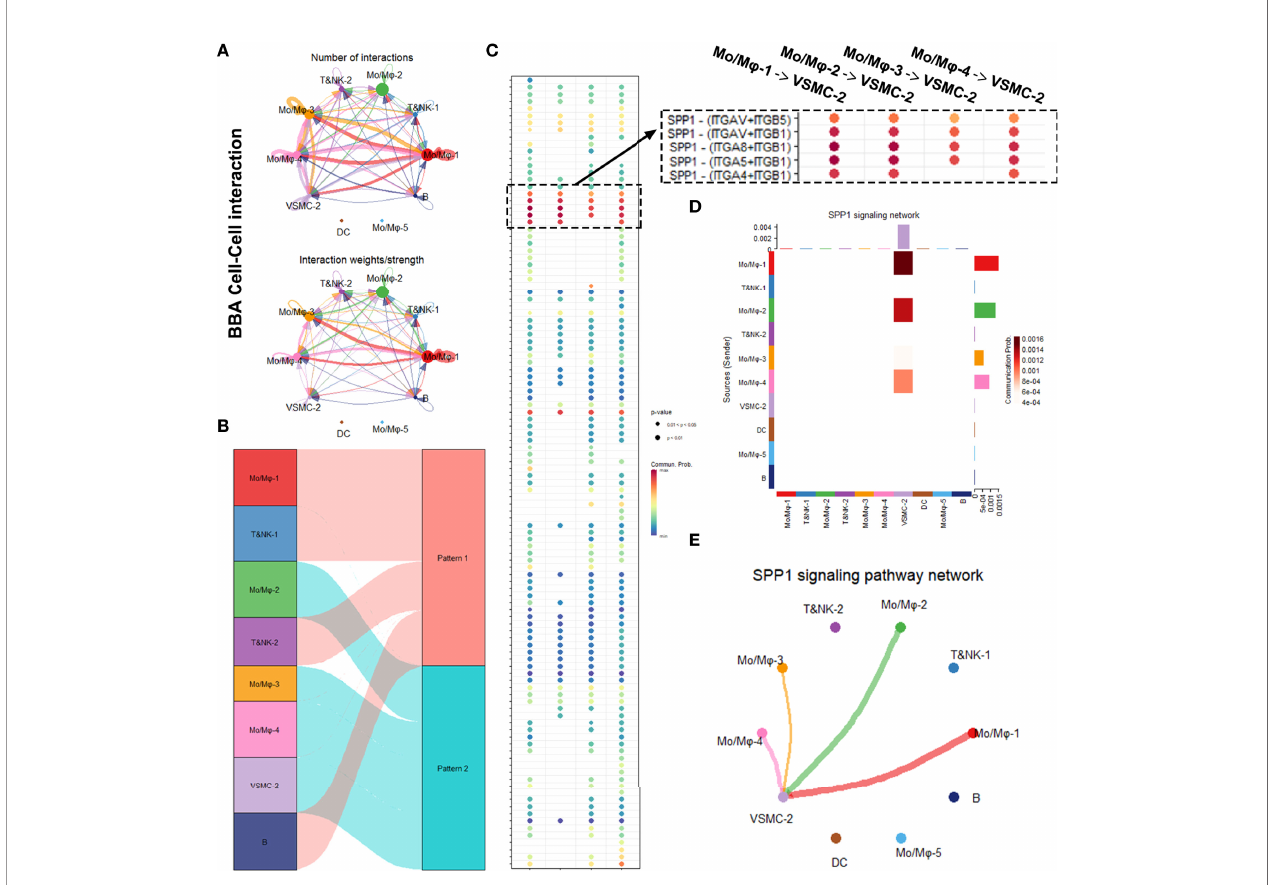
FIGURE 4 | Intracellular analysis between vascular smooth muscle cells (VSMCs) and macrophages in blood blister-like aneurysm (BBA). (A) Net plot showing the interaction number and strength. (B) River plot showing the communicating and working patterns in cells. (C) Network plot showing the speci fi c communicating pathways and their strength. (D, E) SPP1 signaling pathways between VSMC subclusters and macrophages in